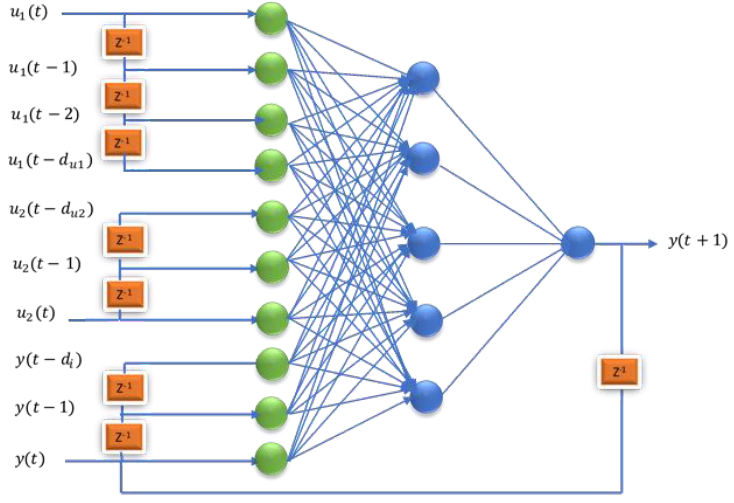
Figure 2. The model architecture of the NARX neural network.